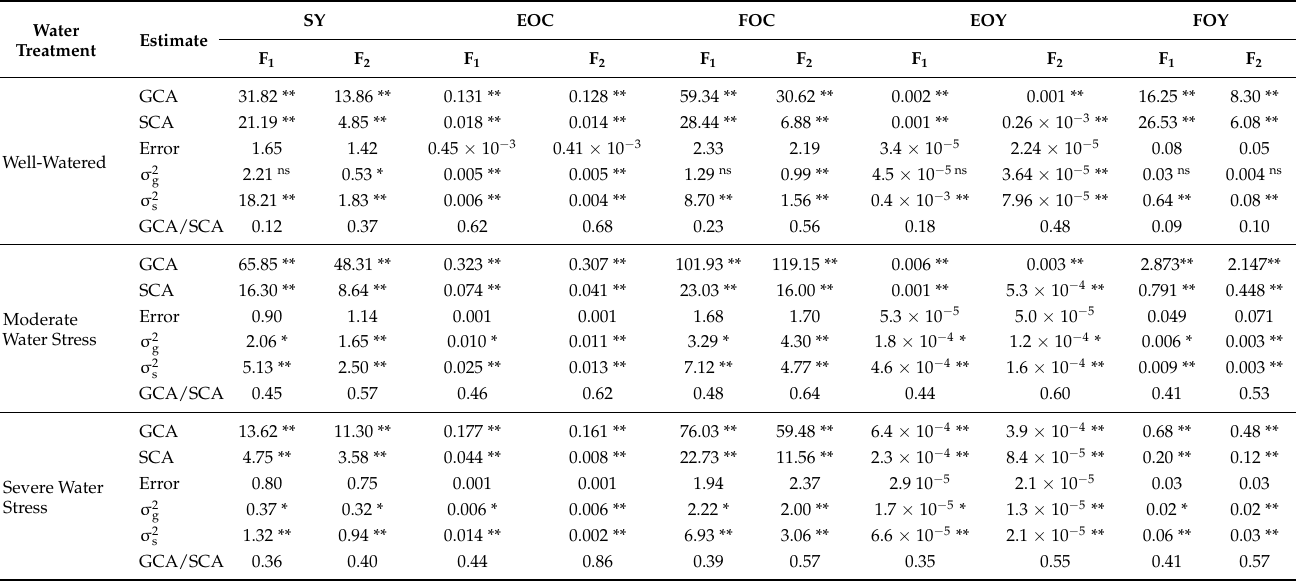
Table 3. Analysis of variance for combining ability, variance components, and GCA/SCA